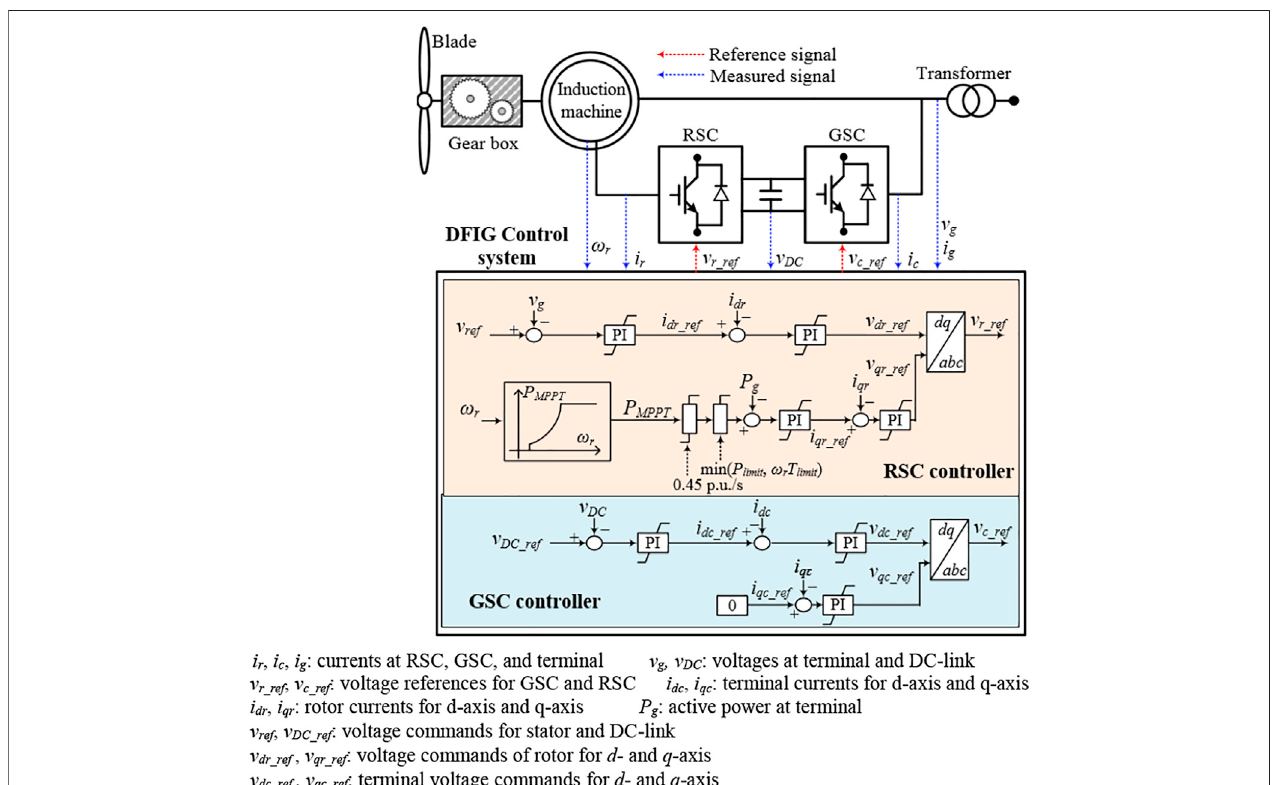
FIGURE 1 | Simpli fi ed doubly fed induction generator (DFIG) control topology.